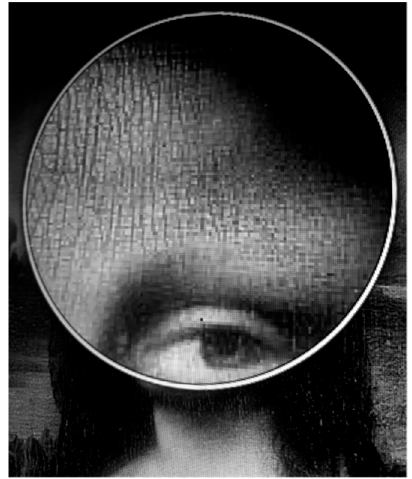
Figure 4. Close up of Mona Lisa’s forehead.